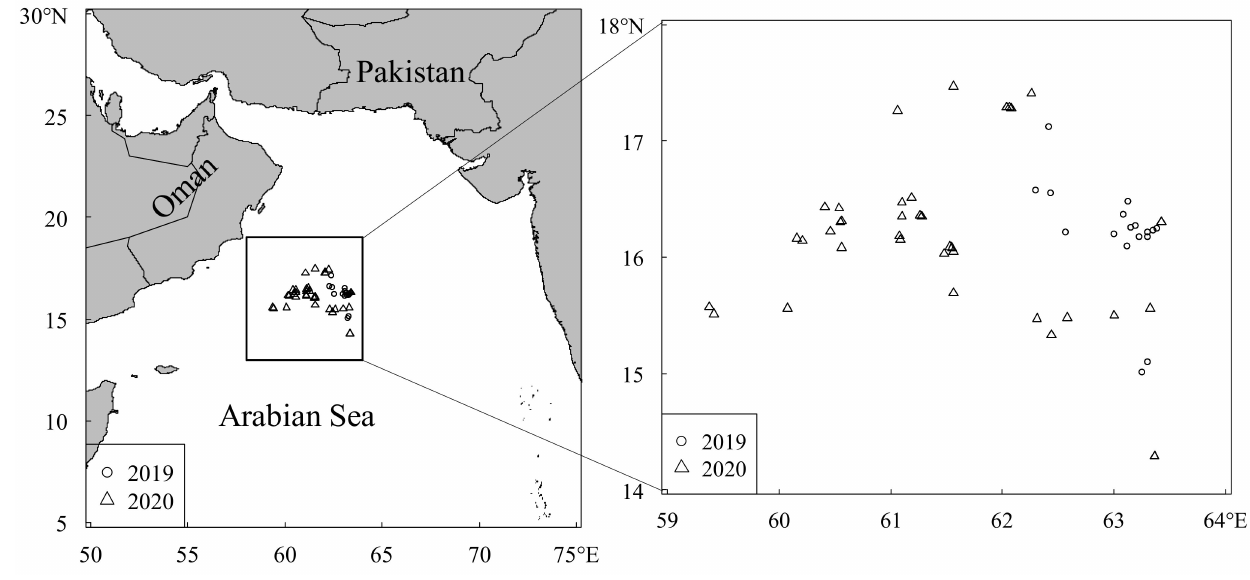
Figure 1. Sample localities of S. oualaniensis in the northwest Indian